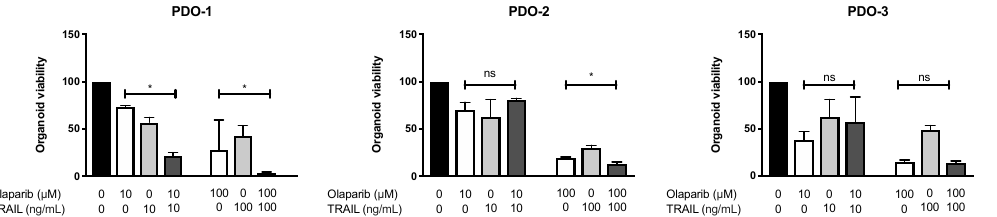
Figure 7. The combination of olaparib and TRAIL enhances antitumor activity in patient-derived pancreatic cancer organoids. CellTiter-Glo assay of organoids derived from three patients with pancreatic cancer (PDO1, PDO2, PDO3) treated with the indicated substances or dimethyl sulfoxide (DMSO) control for 6 days. Error bars represent mean ± SEM from three experiments. * = statistical significance, p < 0.05, ns = non-significant.